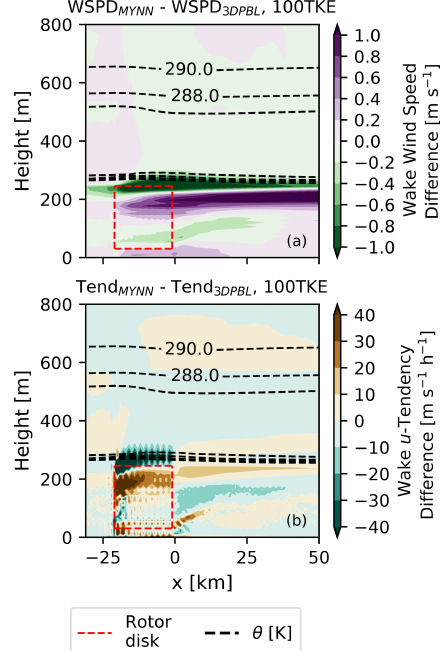
Figure 5. (a) Side view of the difference in wind speed deficits in the stable 100TKE simulations. For example, (a) was calculated as the difference between the results in Fig. 4a–g. (b) The u -tendency deficits in the 100TKE simulations are calculated using a similar procedure involving tendencies. Potential temperature θ values that have been averaged over the y extent of the plant are taken from the MYNN